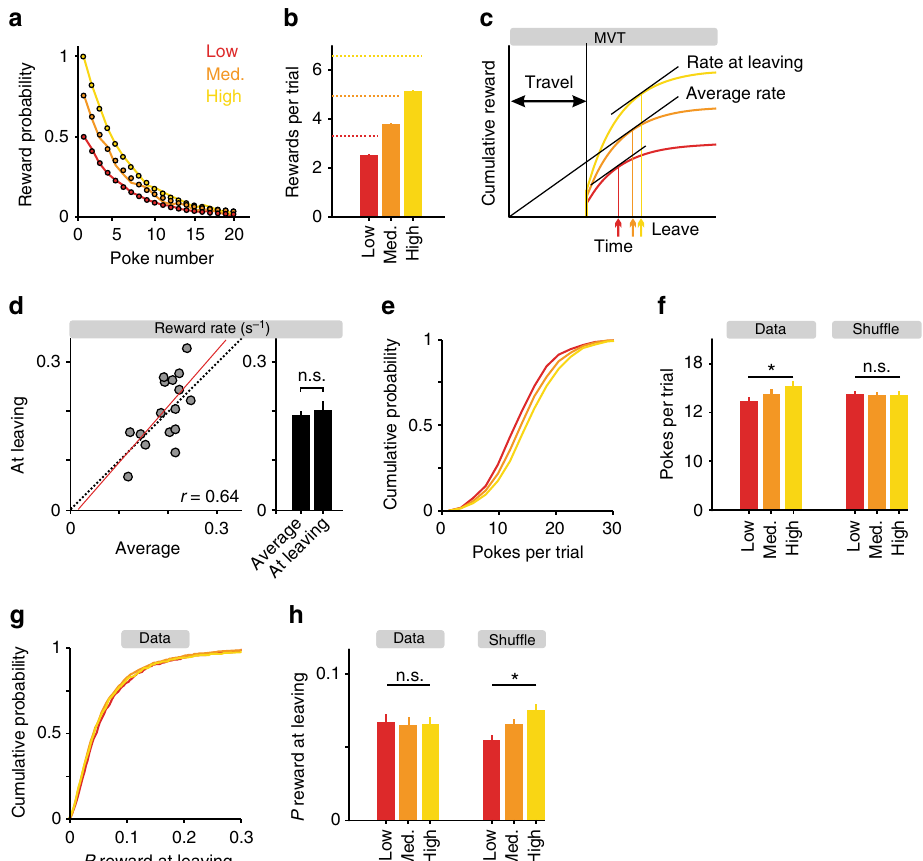
Fig. 2 Reward statistics and task performance. a In each trial, reward probabilities were drawn from one of the three exponentially decreasing functions, all sharing the same time constant but with a different scaling factor, labeled high, medium, and low. Dots mark hypothetical values; solid lines are averages derived from data. b Bar plot showing the average number of rewards in each of the trial types ( n = 16 mice). Dashed lines mark maximal values (assuming mice stay in place and poke inde fi nitely). c Schematic drawing of an optimal-agent ’ s behavior during foraging. When plotting the average cumulative reward as a function of time from reward site exit, the average reward rate is the slope of the line that connects this curve at the time of leaving with the origin. Thus the slope of this line is maximal when it is tangent to the curve. Consequently, better or worse trials result in later or earlier leaving times, respectively (vertical lines and arrows). d Left: Scatter plot of reward rate at leaving vs. average reward rate. Each circle represents one mouse ( n = 16). Dashed line is the unity diagonal and red line is a linear regression curve, with its correlation coef fi cient shown as well ( p < 0.001). Right: Bar plot showing the average reward rate at leaving and the average reward rate. p > 0.05, Wilcoxon signed-rank test. e Cumulative distributions of the number of pokes per trial for the three trial types, averaged across mice ( n = 16). f Bar plot showing the average number of pokes in each of the trial types. Bars on the left represent real data, and bars on the right represent shuf fl ed data. Asterisk indicates signi fi cant effect ( p < 0.05, ANOVA). g Cumulative distributions of the estimated reward probability after the last poke in a trial (i.e., at the time of switching) for the three trial types, averaged across mice ( n = 16). h Bar plot showing the average reward probability after the last poke. Bars on the left represent real data, and bars on the right represent shuf fl ed data. Asterisk indicates signi fi cant difference between trial types, p < 0.05,